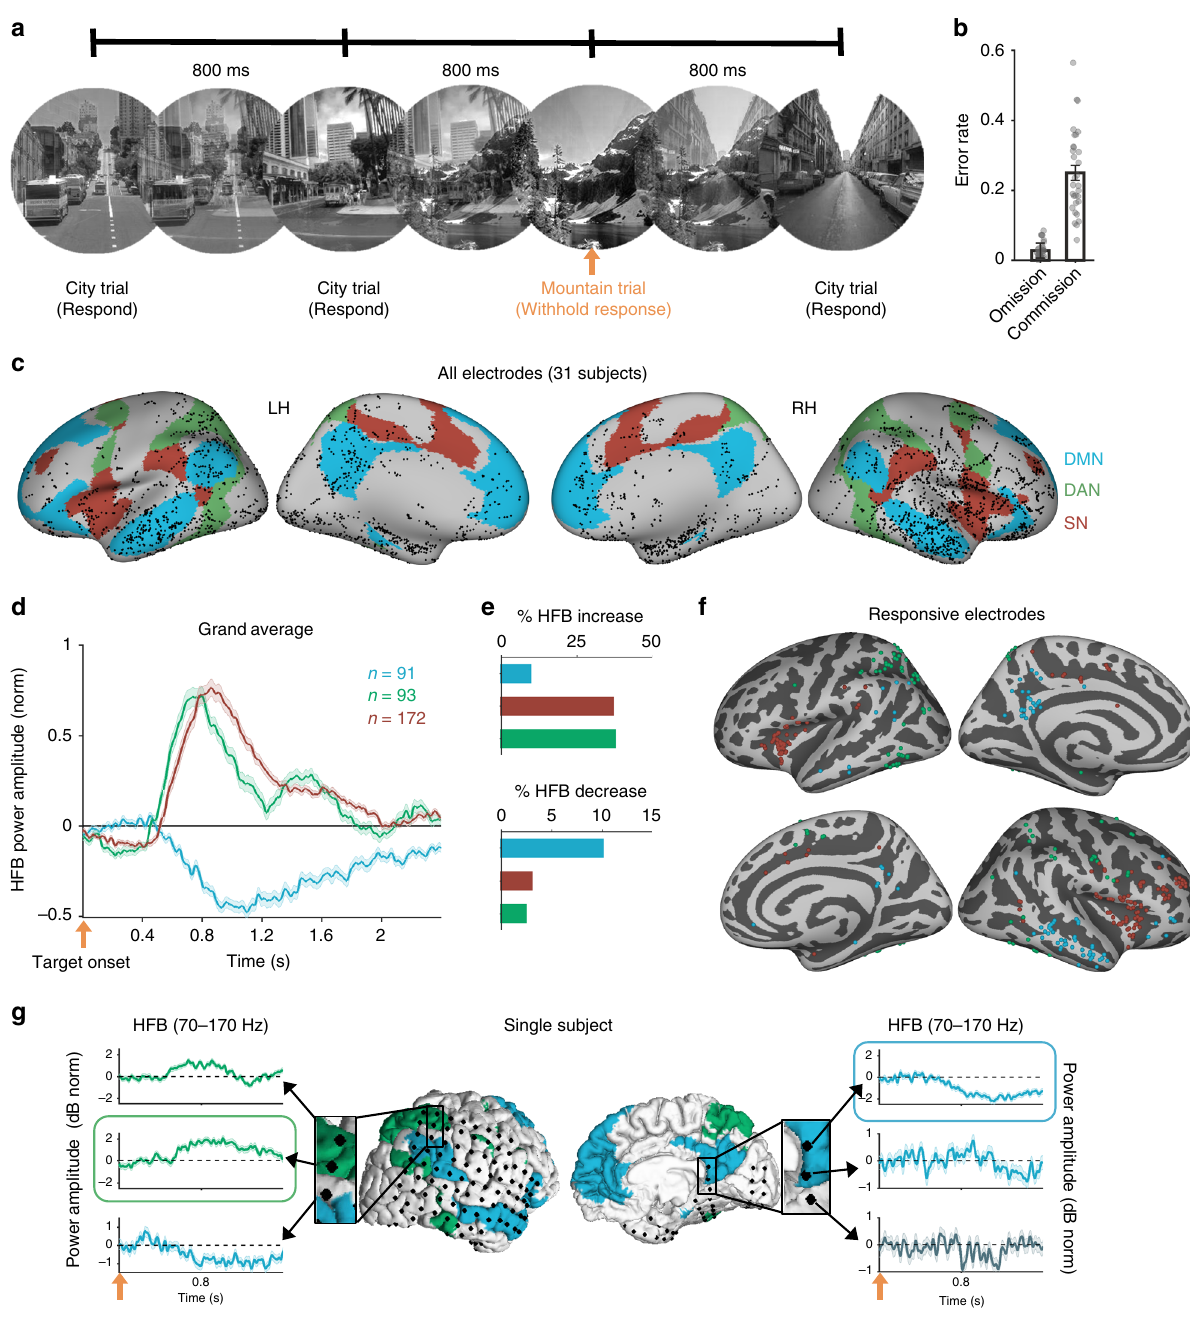
Fig. 1 Task paradigm and functional localization of electrode sites in three networks of interest. a The Gradual-Onset Continuous Performance Task. City and mountain scene images (from the SUN database 99 ) faded continuously from one image to the next every 800msec. Trial onset (orange arrow) was the time at which stimulus fade-in was initiated. b Omission and commission error rates, averaged across runs, in 31 subjects. c Anatomical locations of cortical electrode contacts in 31 subjects, projected to fsaverage standard space and overlaying the Yeo atlas ’ DMN (blue), DAN (green), and SN (red). d High-frequency broadband (HFB; 70 – 170 Hz) responses during the presentation of mountain (target) stimuli. Time courses show the grand average of the trial-wise means within all responsive electrodes ( p < 0.05, cluster-based permutation test, corrected for multiple comparisons within networks within subjects) across the entire patient cohort. e Relative proportions of electrodes within each network showing signi fi cant target-evoked HFB increase (top) and decrease (bottom). f Locations of responsive electrodes within each network (fsaverage space). g Subdural electrodes plotted on the cortical surface with an overlay of the Yeo atlas ’ DMN (blue) and DAN (green) in an example subject. Time series plots illustrate diverging HFB response pro fi les among neighboring electrodes (peak-responsive electrodes in the dPPC and PMC, respectively, are outlined in green and blue). Where relevant, error bars indicate standard error of the